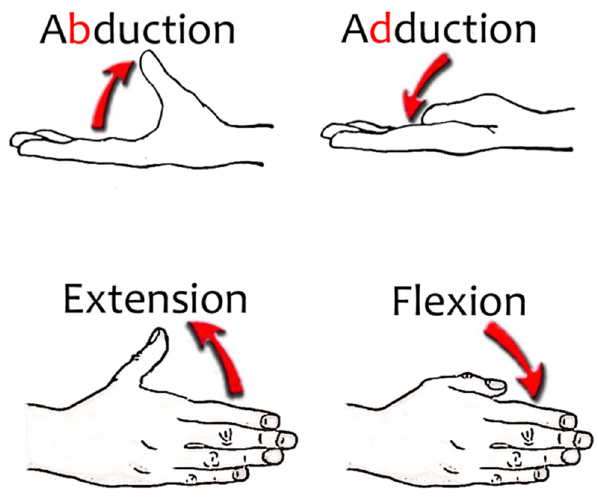
Figure 3. Thumb Figure 3. Thumb movements.